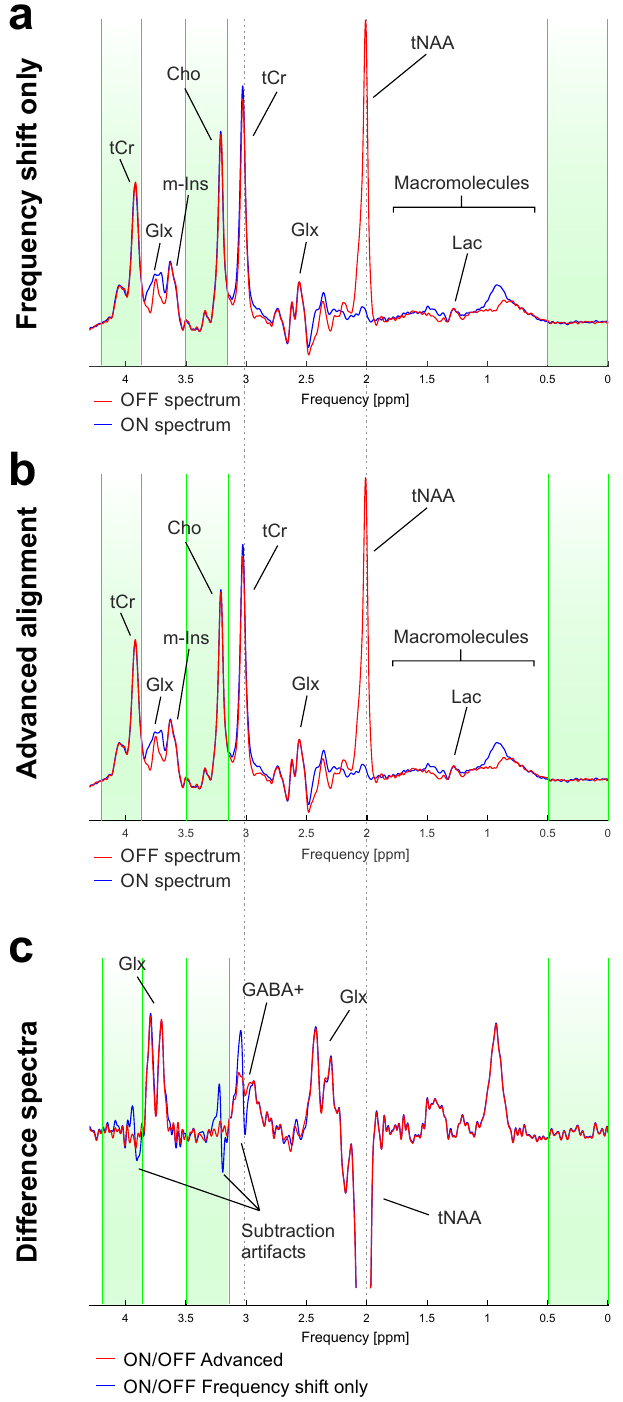
Figure 4. Spectra from J -difference editing experiment for GABA acquired from auditory cortex in a healthy adult at 3 T with chosen frequency ranges for alignment shown as green vertical areas. ( a ) Spectra aligned only for frequency shift (blue: ON, red: OFF). ( b ) Spectra with advanced alignment (blue: ON, red: OFF). ( c ) The difference spectrum based on frequency alignment alone (blue) shows severe subtraction artifacts despite a lack of large dissimilarities between the two conditions ( a ), whereas the difference spectrum with advanced alignment (red) is clean and free of subtraction